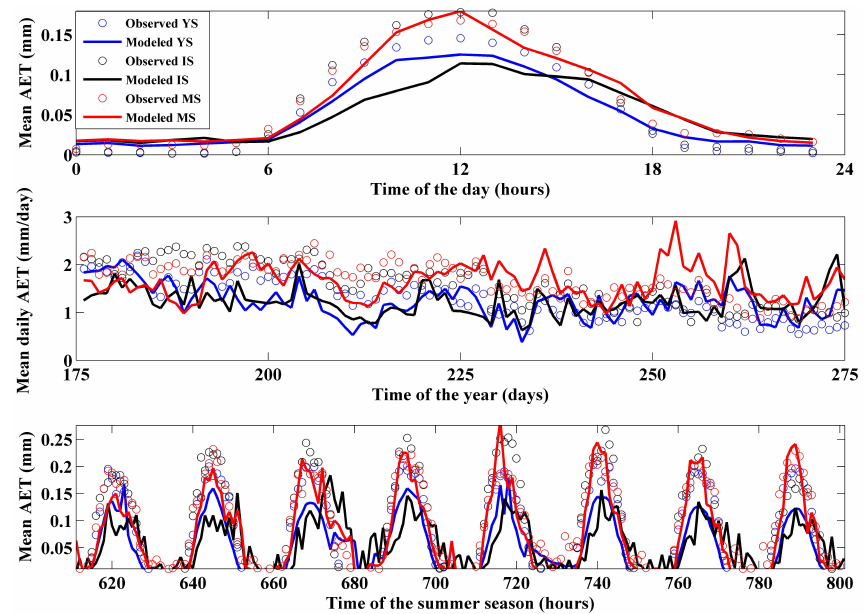
Fig. 2. Modeled and observed summer AET (2001–2008) based on Z r =30cm, I max =0.25mmh − 1 and 1t =60min: (top) mean diurnal cycle simulated (middle) mean daily AET values simulated (bottom) mean hourly AET values simulated (zoomed in from the whole time